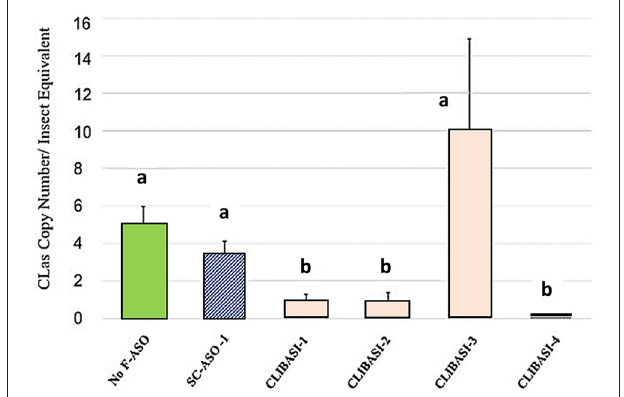
FIGURE 3 | Psyllid ingestion of FANA ASO targeting DNA Ligase-A (CLIBASIA) reduced CLas titers in infected-psyllid given a 6-day feeding access period on FANA treated citrus leaves. Changes in CLas bacteria copy number in CLas-carrying psyllids after feeding on individual FANA leaf treatments shown. Error bars represent ± SE of the mean from six biological replicates, from three replicates. Bars with the same letter are not significantly different.